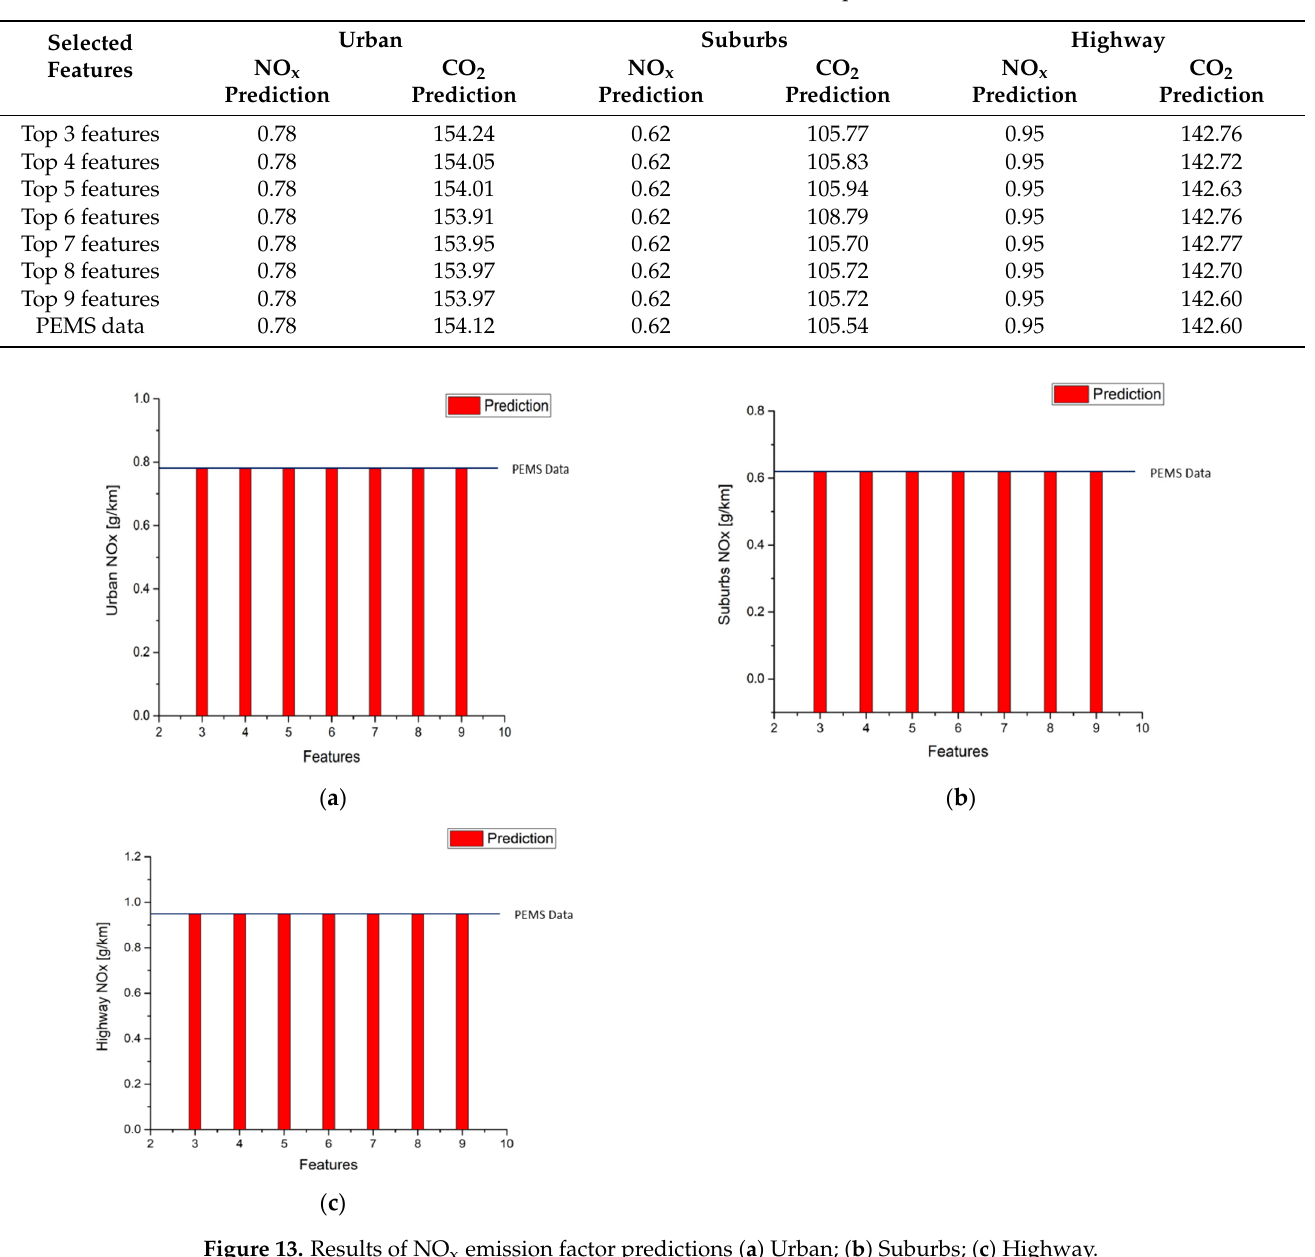
Table 14. Results of NO x and CO 2 emission factor predictions.